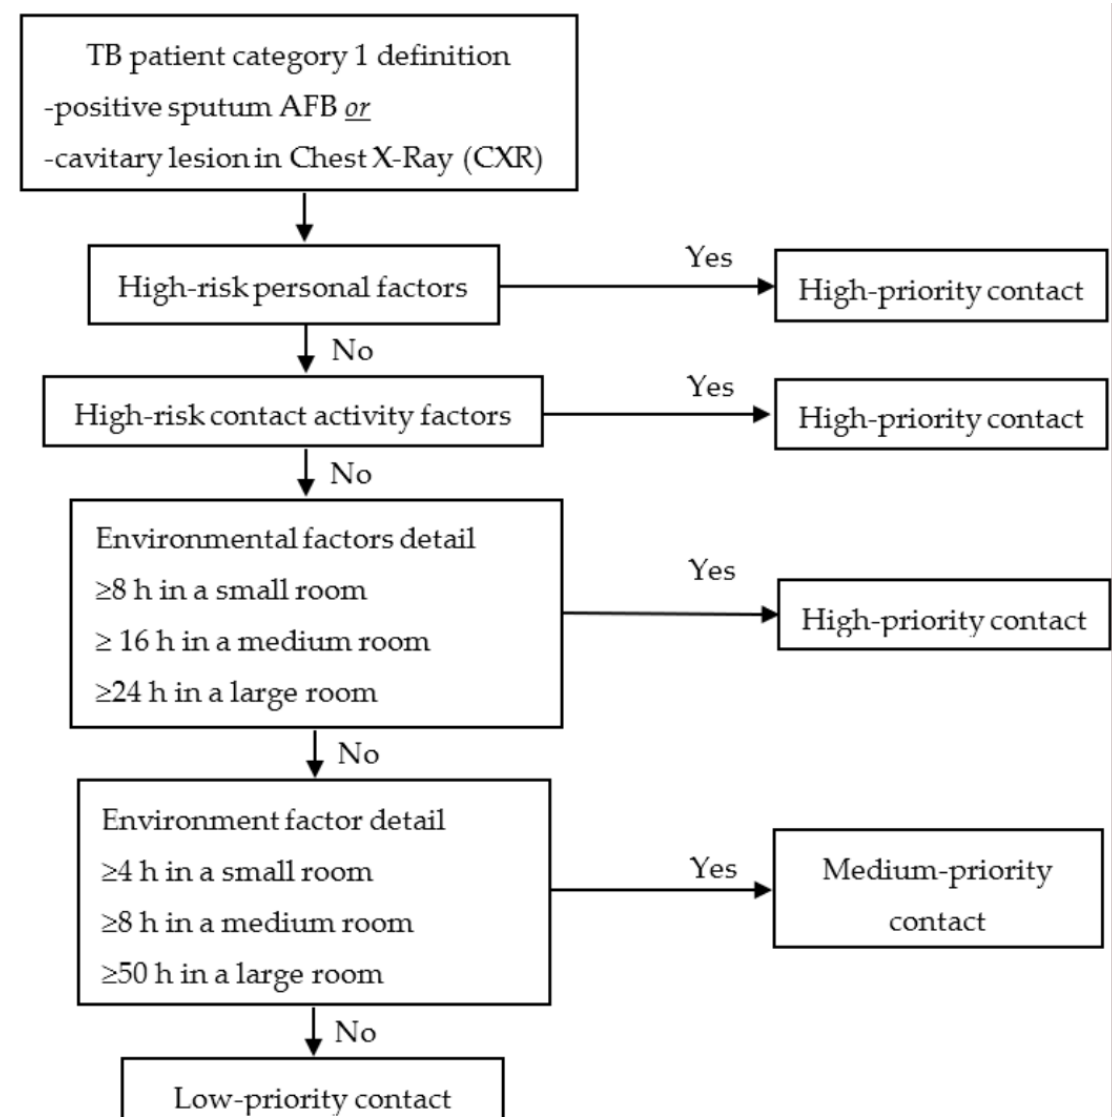
Figure 1. Prioritization of contacts exposed to tuberculosis (TB) Patient Category 1. (Source: OH&S Faculty of Medicine KKU